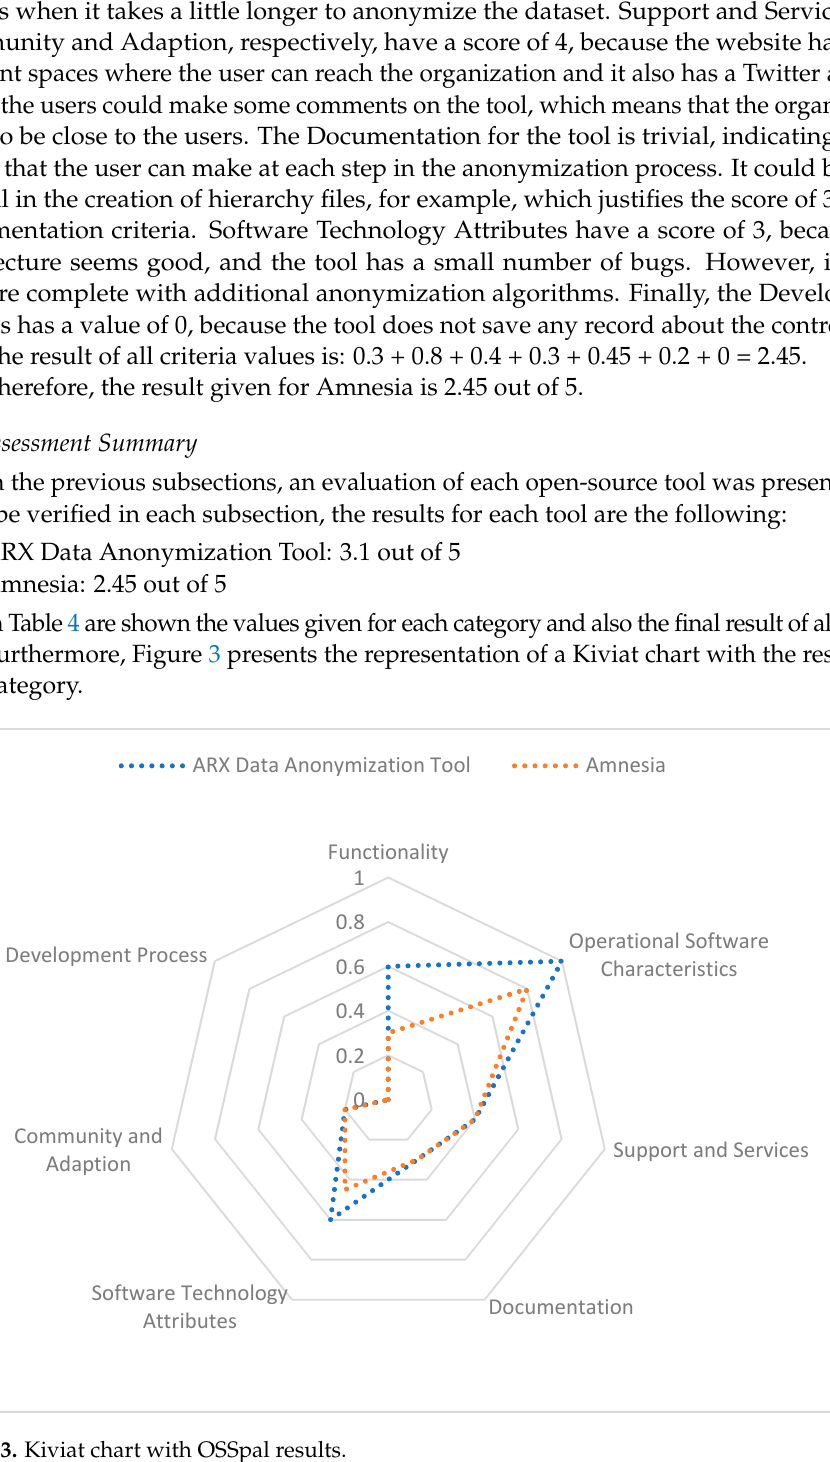
Table 4. Category Results.